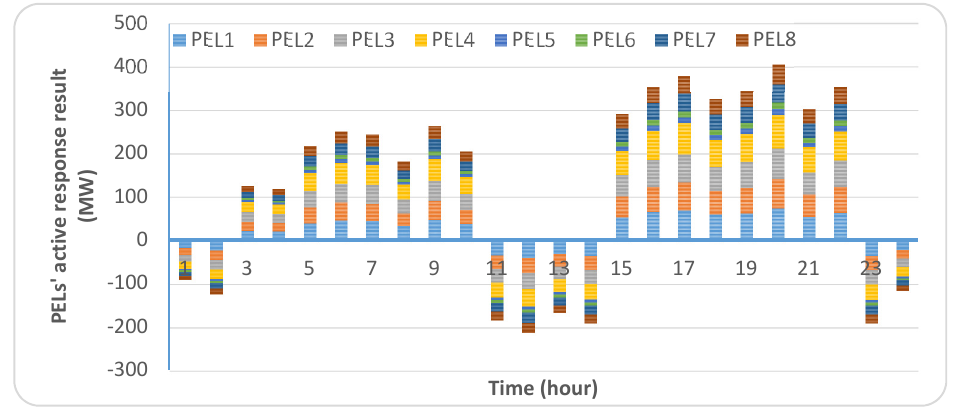
Figure 4. Demand response amounts of PEL.